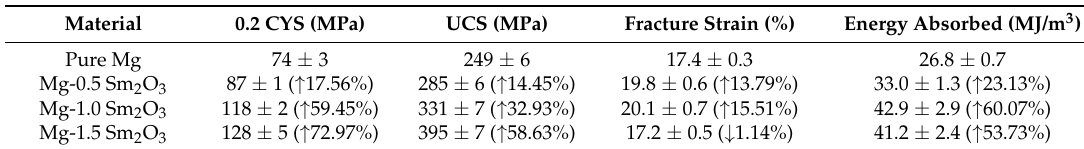
Table 4. Results of room temperature compression testing.